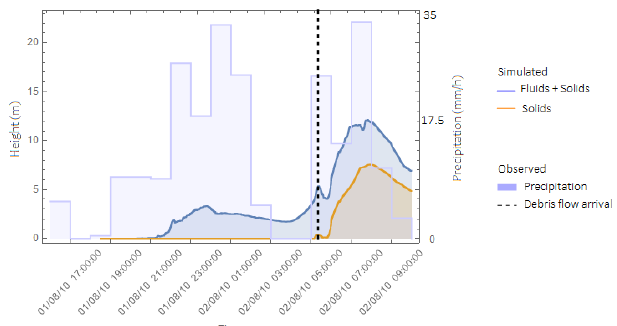
Figure 12. Time series data for rainfall, total flow height, and solid flow height at the Hongchun outlet. Reported debris flow occurrence time is indicated as “debris